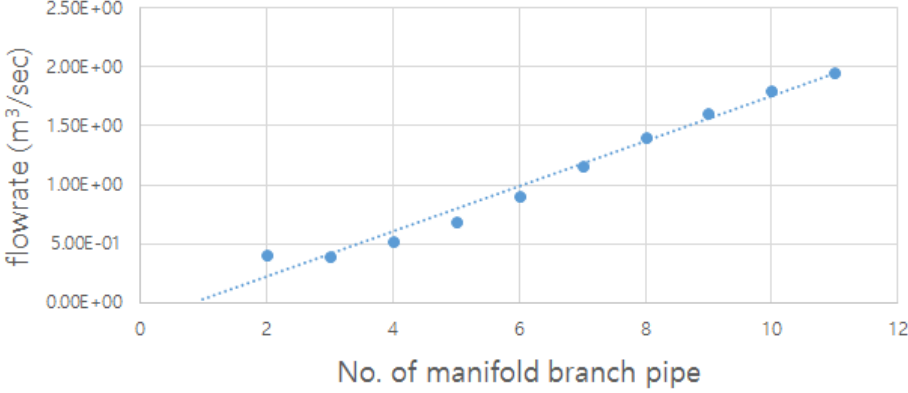
Figure 8. Flow distribution pattern from CFD simulation results.